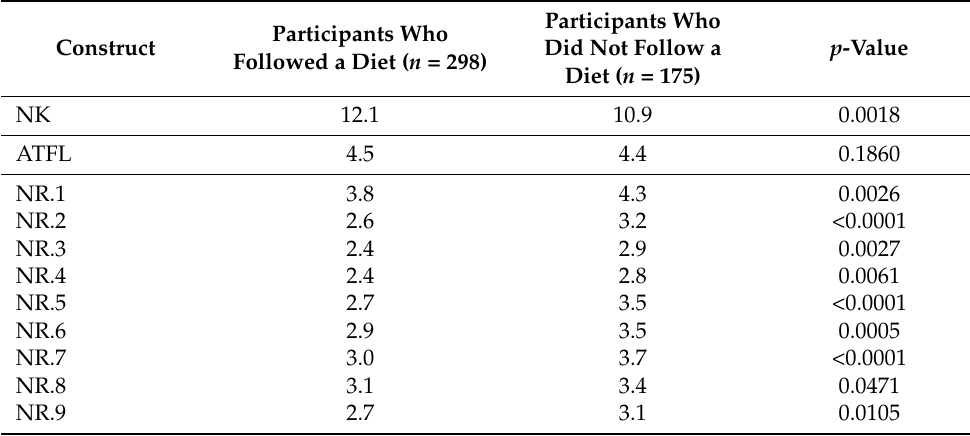
Table 2. Mean values and p -value for each item or construct of the questionnaire and label reading percentages for the participants who did and did not follow a